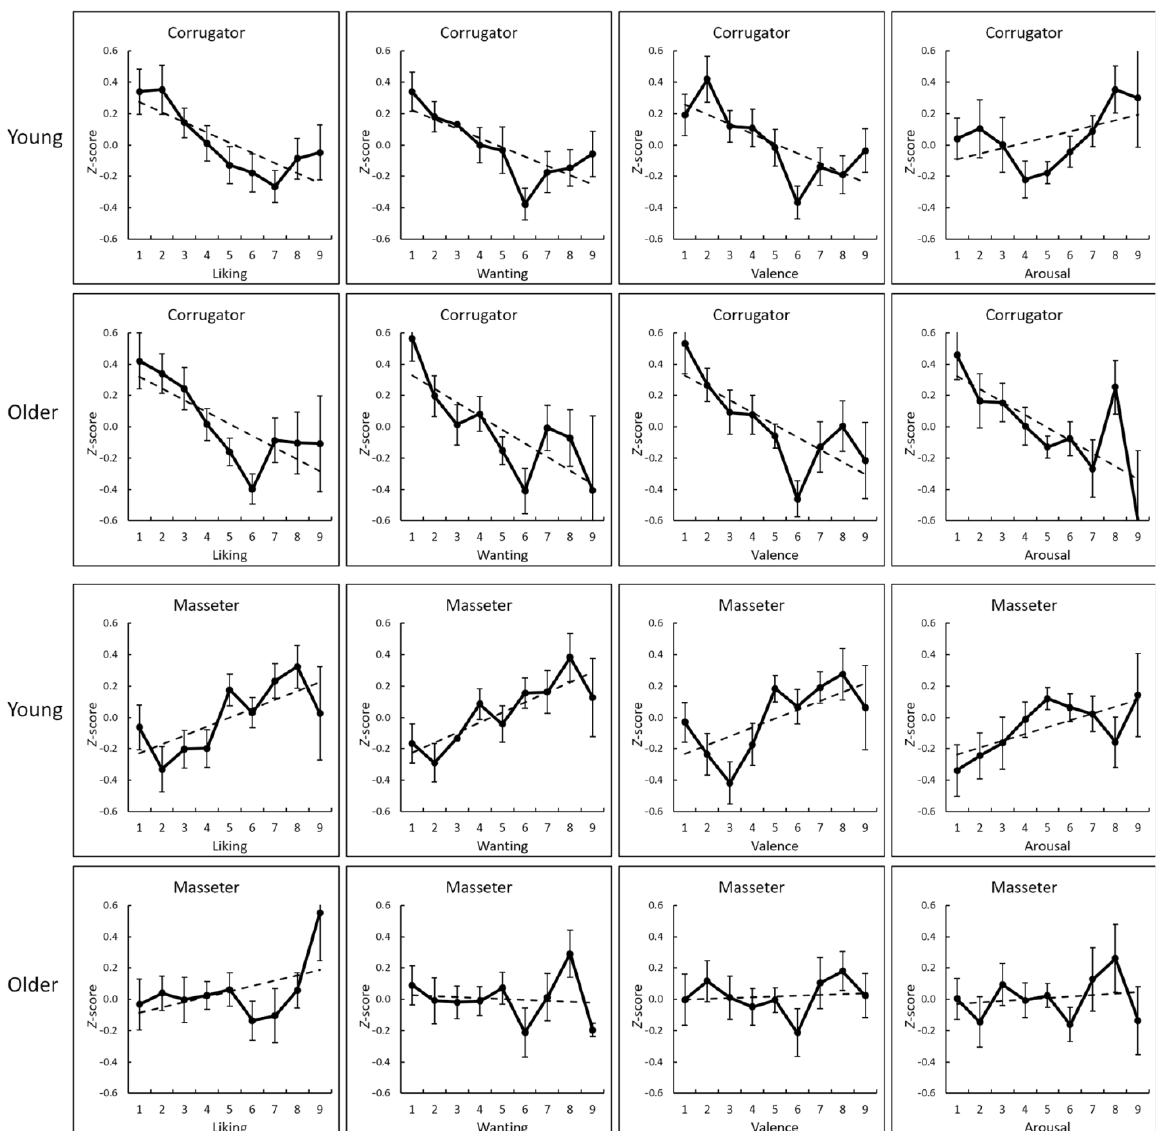
Figure 2. Group mean (with SE) values and regression lines of the subjective ratings (liking, wanting, and valence) and electromyography activity of the corrugator supercilii and masseter muscles in the young and older adult groups (standardized for each individual).